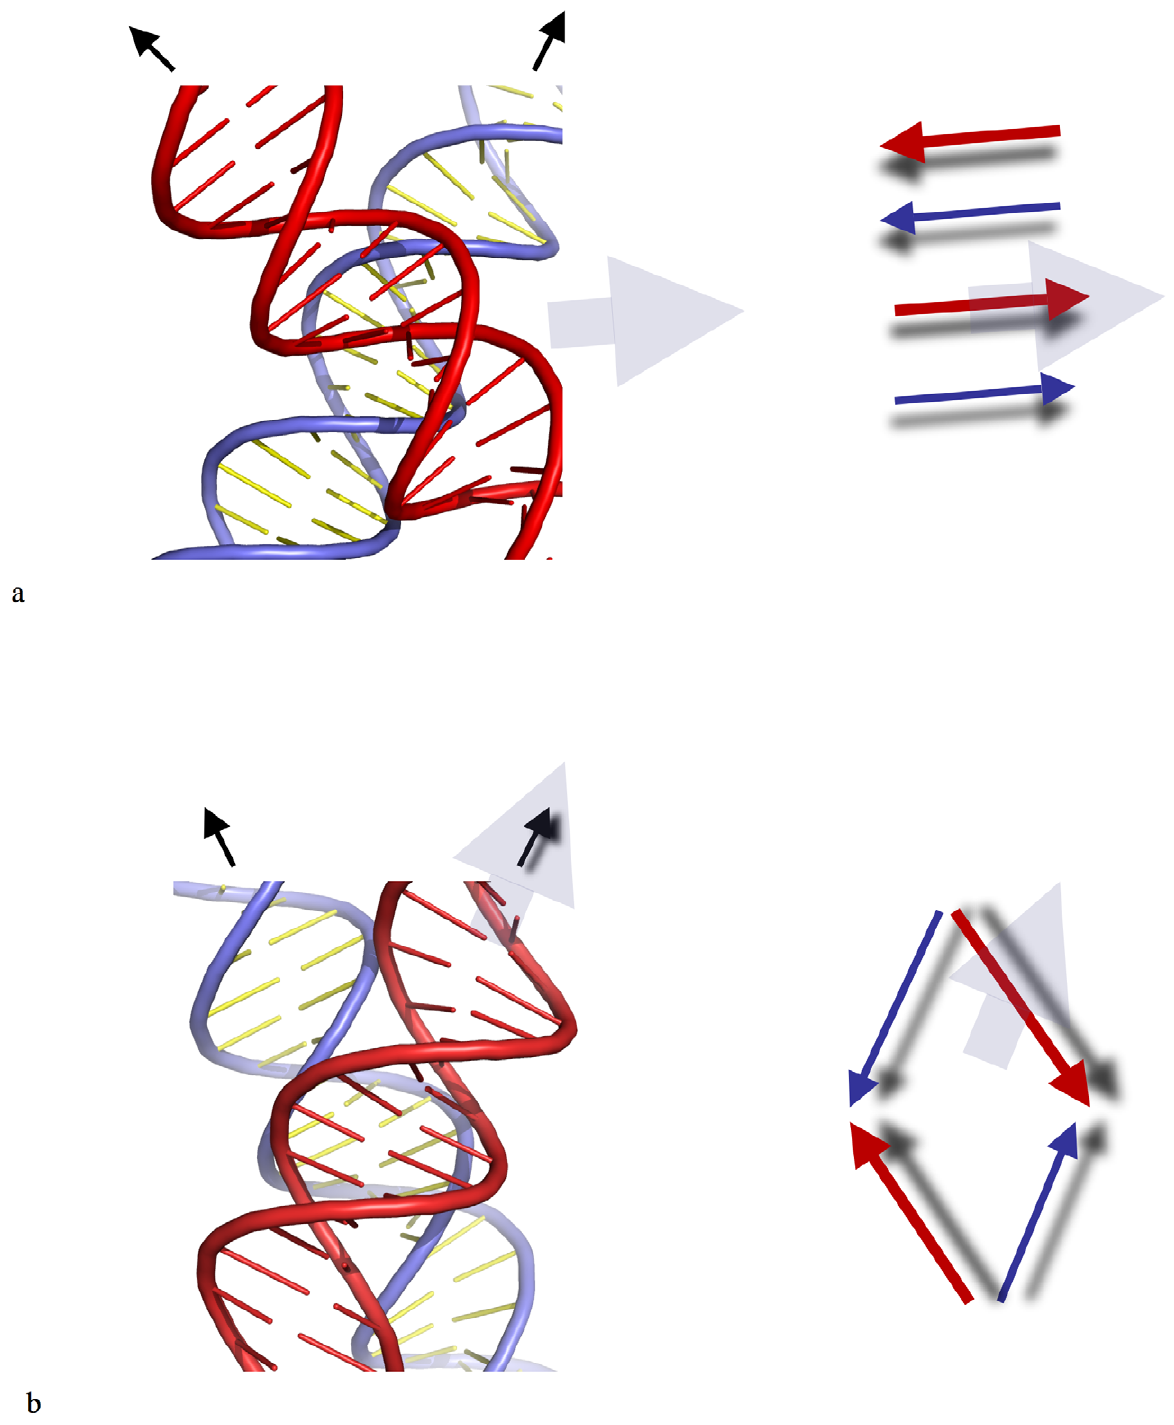
Figure 2. DNA chirality and geometry of crossovers. (a) Detailed view of the major groove-backbone interaction. (b) Detailed view of the major-groove/major-groove interaction. The front helix is represented in red and the back helix in blue. The thin black arrows indicate the directions of the helical axes, and the large grey arrows indicate the direction of the major groove in the back helix. On the right, the red and blue arrows indicate the backbones at the interface of the crossovers in the 5 9 -3 9 direction. In right-handed crossovers, the backbone of one helix (red) is oriented along the direction of the major groove of the other one (blue). In left-handed crossovers, the helical axis of one helix (red) is oriented along the direction of the major groove of the other one (blue).